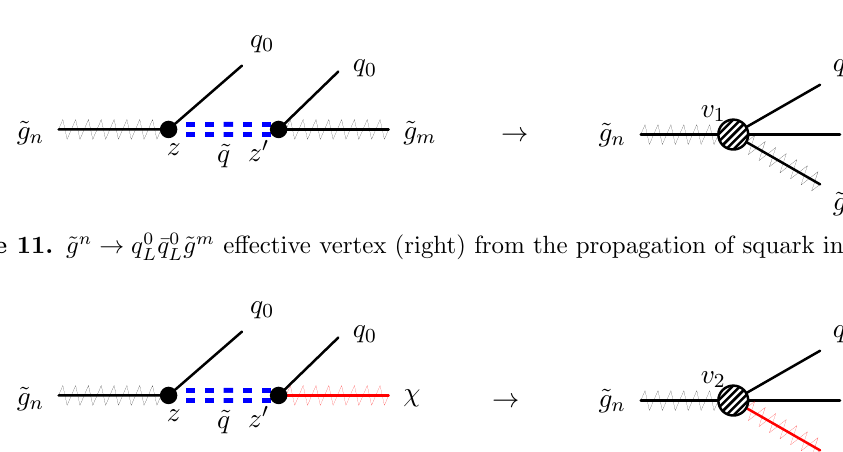
Figure 12. ~ g n ! q 0